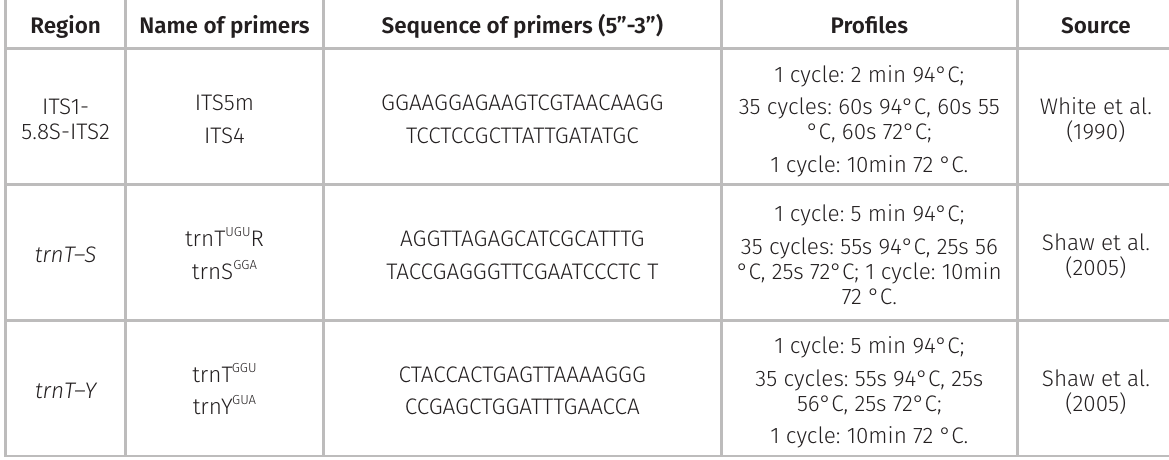
Table II. The primers and PCR condition for the three regions analyzed.